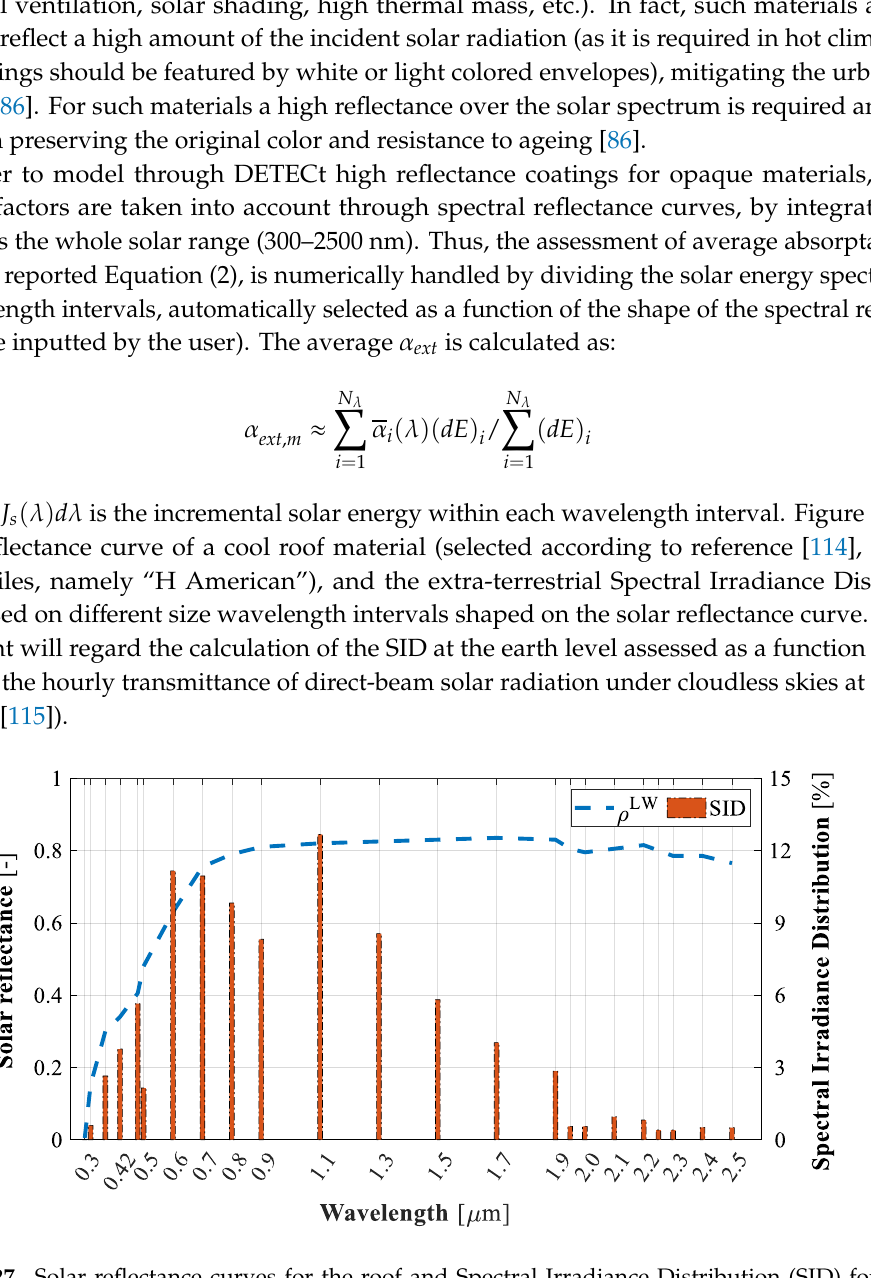
Figure 27. Solar reflectance curves for the roof and Spectral Irradiance Distribution (SID) for the considered wavelength intervals.